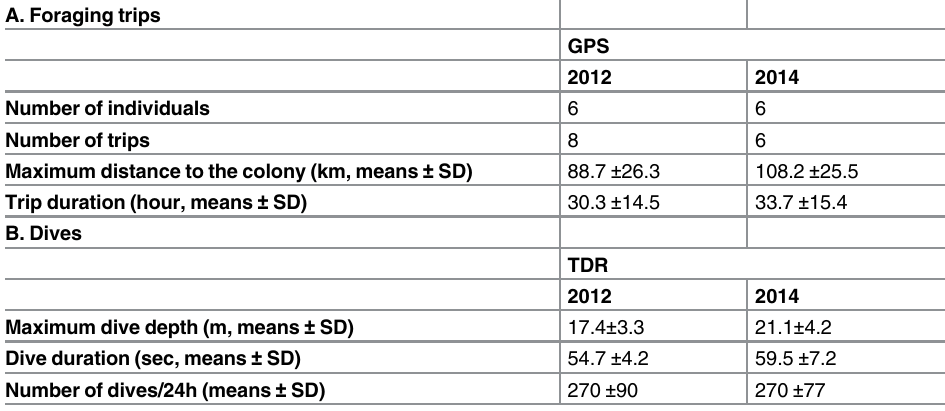
Table 1. Statistics summary for (A) foraging trips performed by little auks equipped with GPSs (2012 and 2014); and (B) dives performed by little auks equipped with TDRs (2012 and 2014).